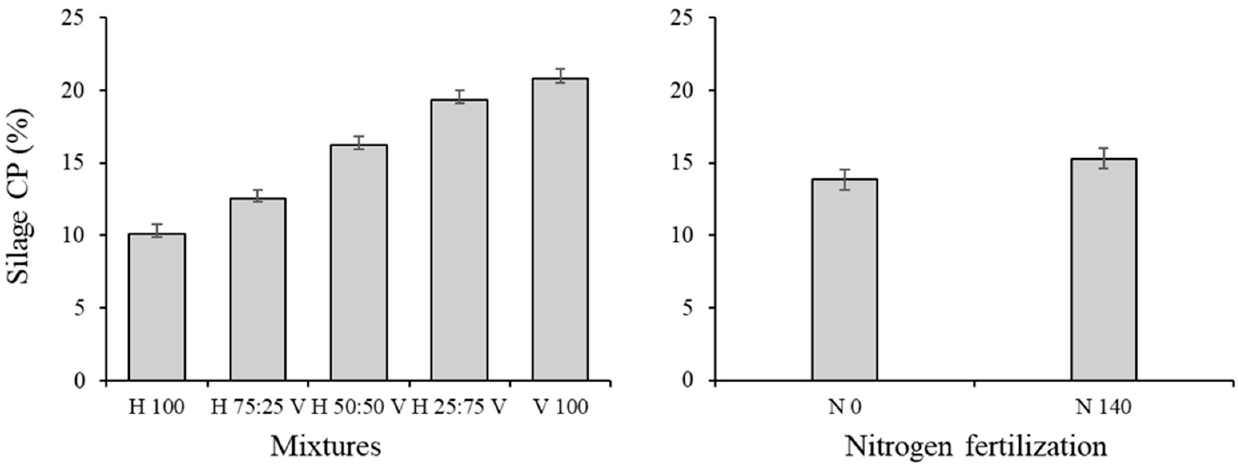
Figure 9. Silage CP as affected by MX mean effect ( right ) and NF mean effect ( left ). On the left, values are LSmeans across all treatments along with standard error estimate of the LSmeans since the design was unbalanced between the faba bean crop ( n = 9) compared to the mixtures and the barley crops ( n = 18). On the right, only data of the barley-containing treatments were used. Each point represents the arithmetic mean ( n = 24) and its computed standard error.